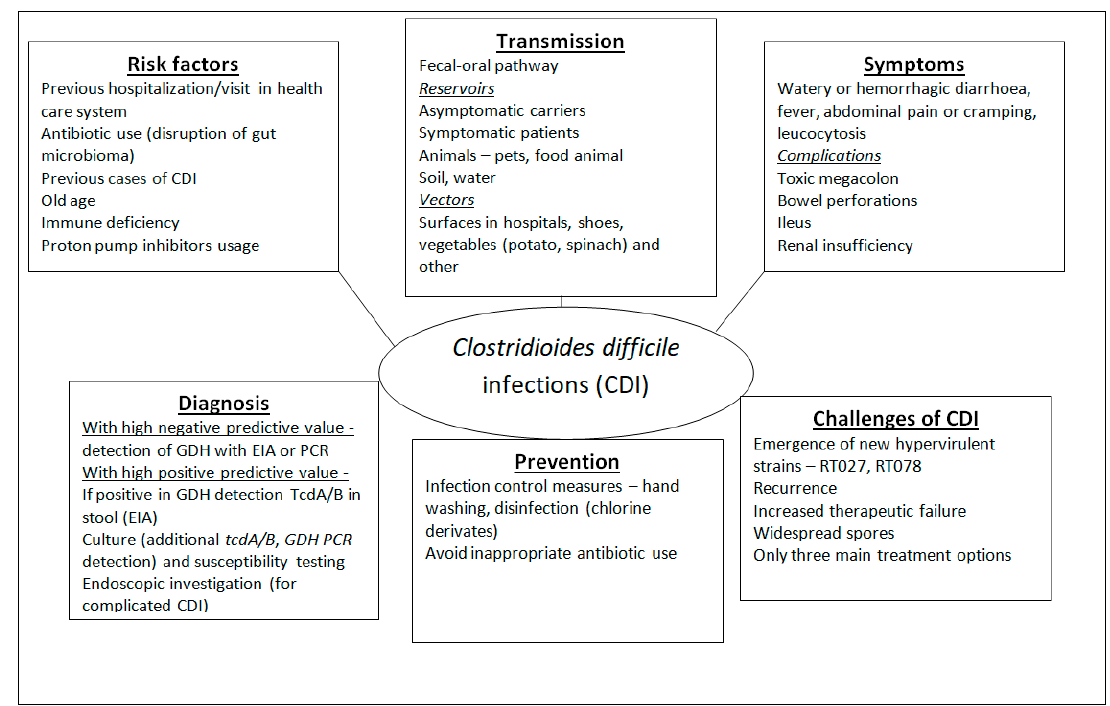
Figure 1. Main characteristics of Clostridioides difficile infections [9,10,17]. Abbreviations: EIA—enzyme immunoassay; GDH—glutamate dehydrogenase.